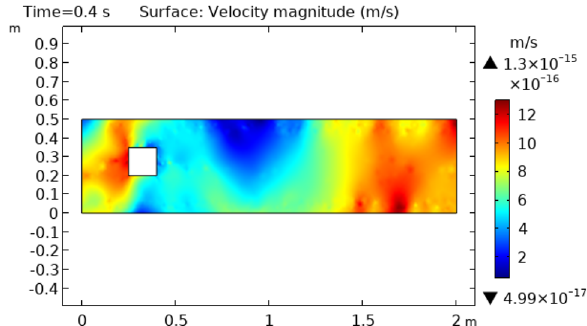
Figure 3. Velocity distribution in squared cylindrical flow at t = 0.4 s.